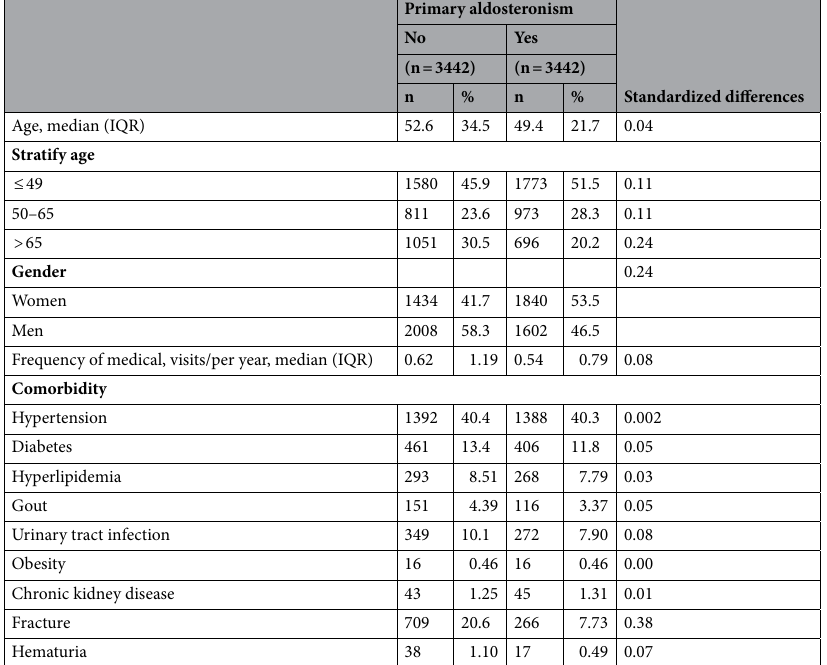
Table 1. Comparison of demographic characteristics and comorbidity between PA versus a non-PA cohort by propensity score matching method. IQR interquartile range, PA primary